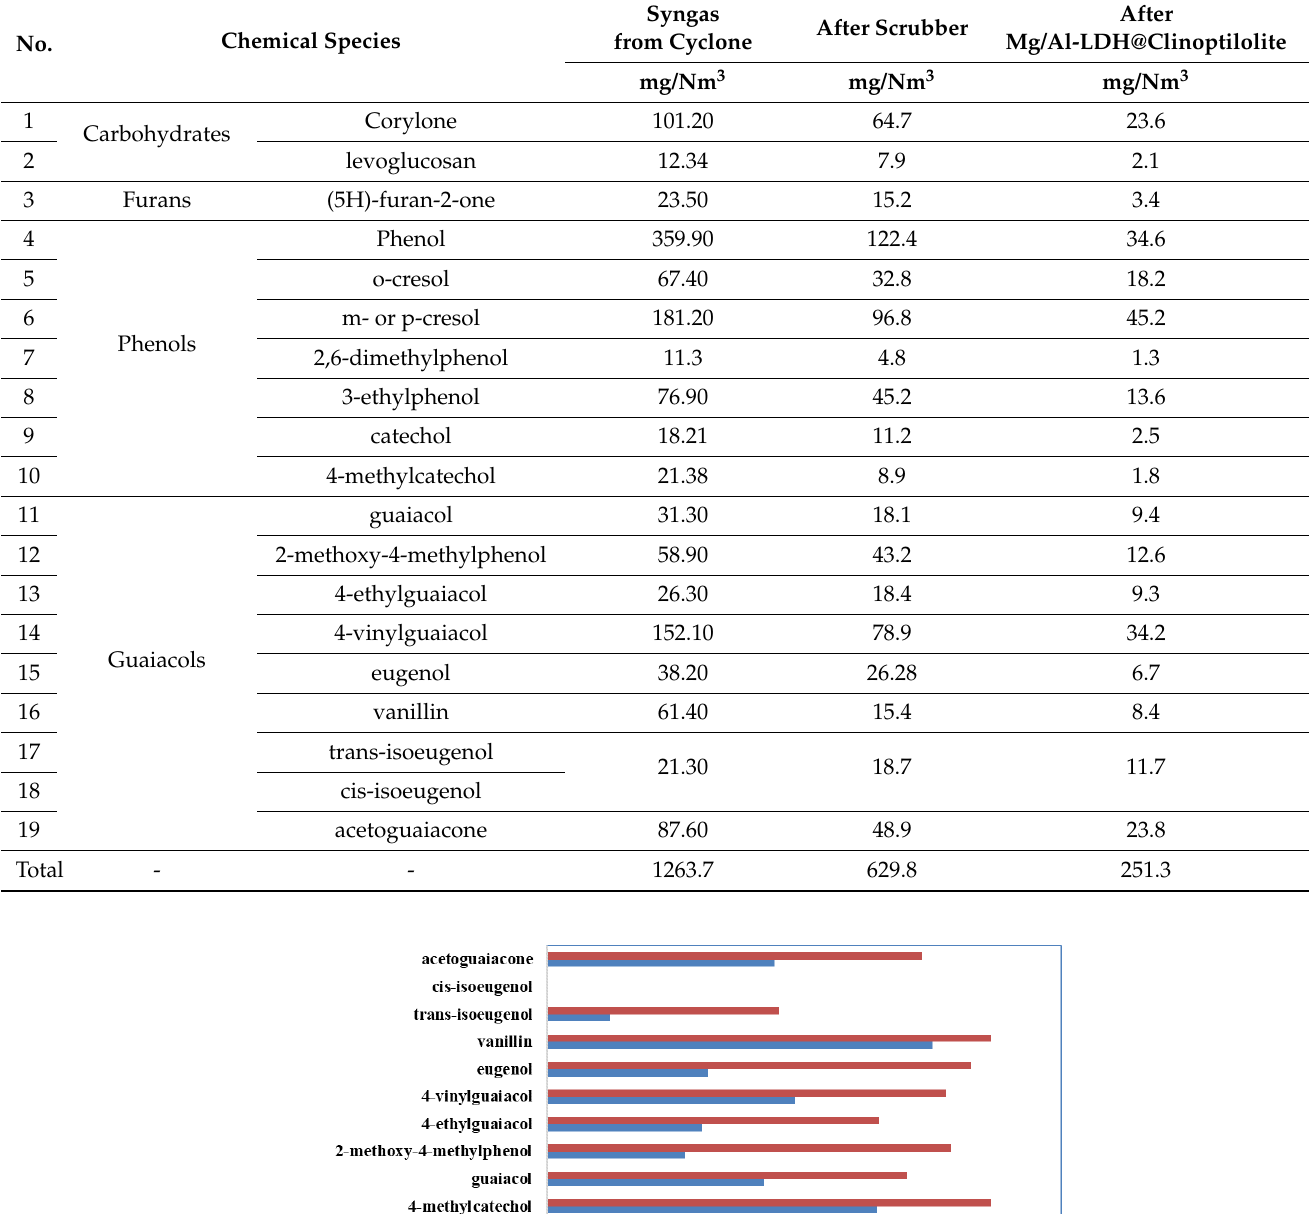
Table 2. Concentrations of generated tar compounds and the tar compound content in the syngas for each removal process.